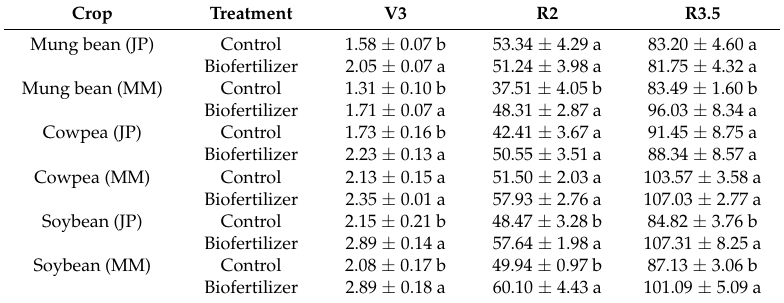
Table 8. Effect of biofertilizer on P uptake (mg pot − 1 ) of mung beans, cowpeas and soybeans at different growth stage.